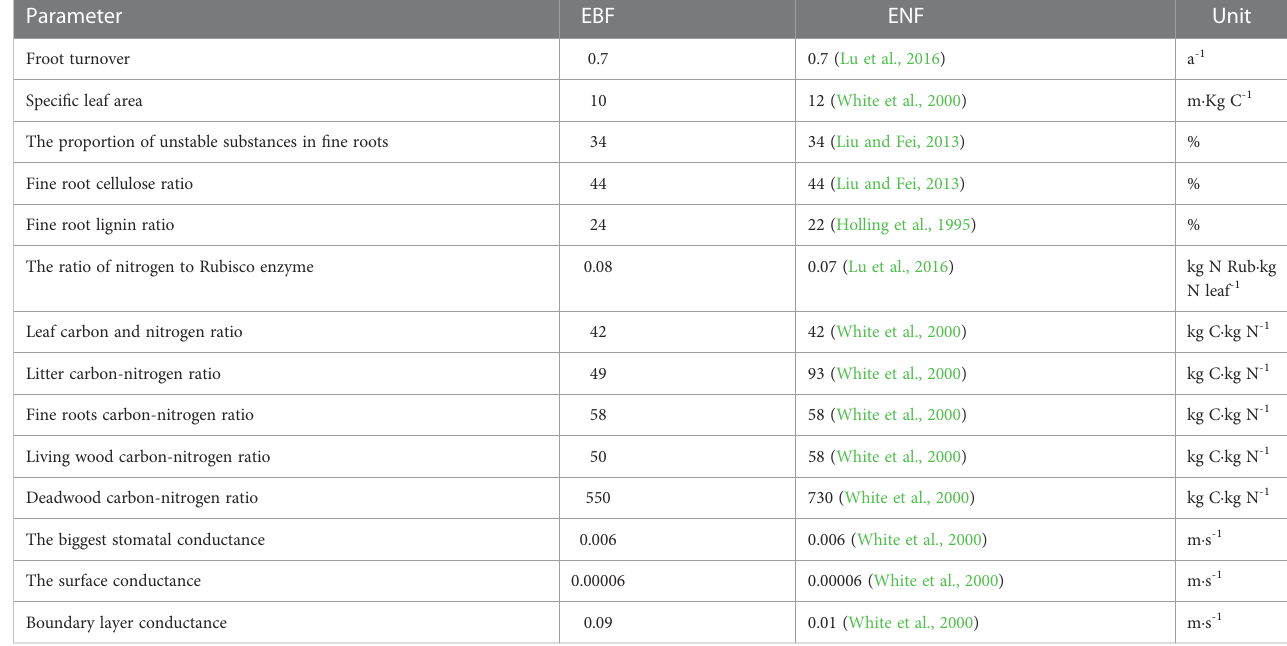
TABLE 3 Main parameters input to the Biome-BGC model.